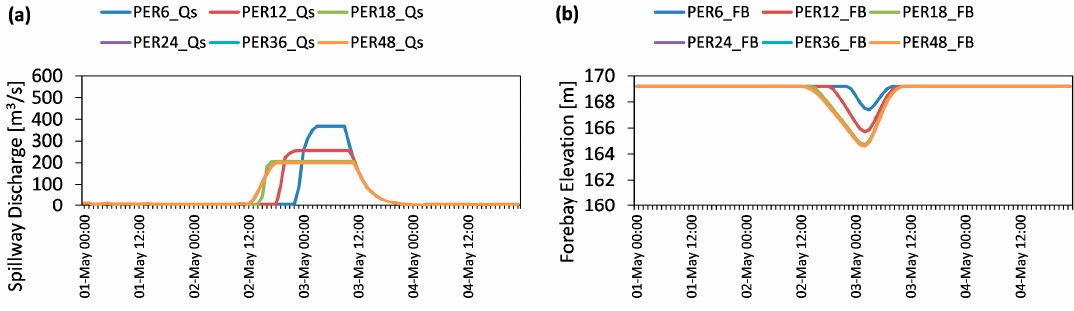
Figure 7. Comparison of closed-loop MPC forecast horizon performance using perfect streamflow forecasts: ( a ) Spillway discharge (m 3 /s); ( b ) forebay elevation (m).